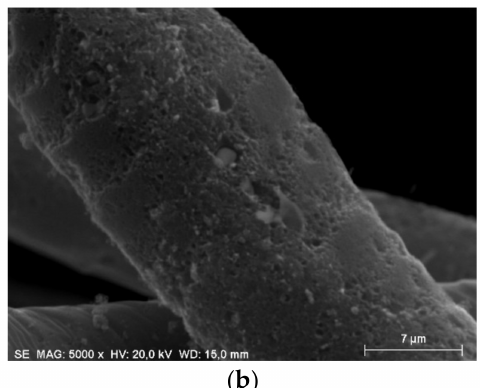
Figure 3. A 5000 × magnification SEM image of the ACF’f, front view of the hollow material ( a ), and a view of the surface ( b ).